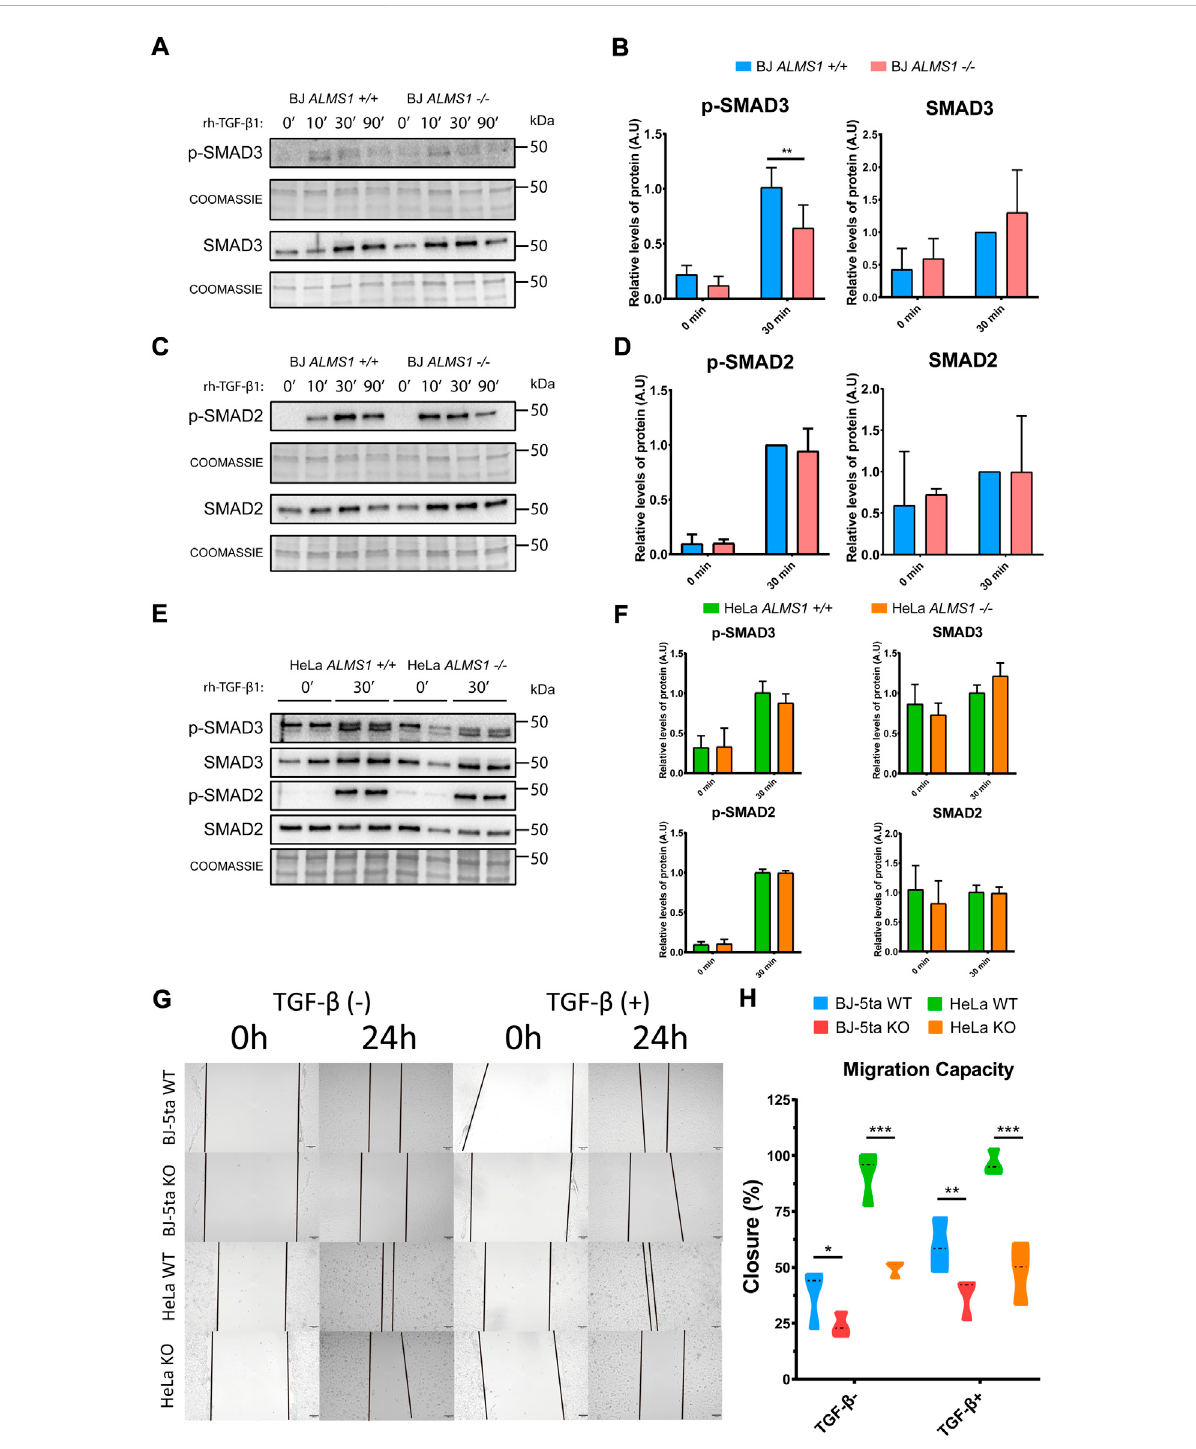
FIGURE 6 TGF- β canonical pathway activation assay and measurement of cell migration capacity in HeLa and BJ-5ta. (A) Representative western-blot of p-SMAD3 and SMAD3 levels after 0, 10, 30 and 90 min of stimulation with TGF- β 1 (2 ng/ μ L) ligand and their corresponding loading controls (coomassie) in BJ-5ta cells ( n = 3). (B) Quanti fi cation of band intensity in WB for p-SMAD3 and SMAD3 at time 0 and after 30 min stimulation with TGF- β 1. *: p -value < 0.05, **: p -value < 0.01 (C) Representative western-blot of p-SMAD2 and SMAD2 levels after 0, 10, 30 and 90 min of stimulation with TGF- β 1 (2 ng/ μ L) ligand and their corresponding loading controls (coomassie) in BJ-5ta cells ( n = 3). (D) Quanti fi cation of band intensity in WB for p-SMAD2 and SMAD2 at time 0 and after 30 min stimulation with TGF- β 1. *: p -value < 0.05, **: p -value < 0.01. (E)